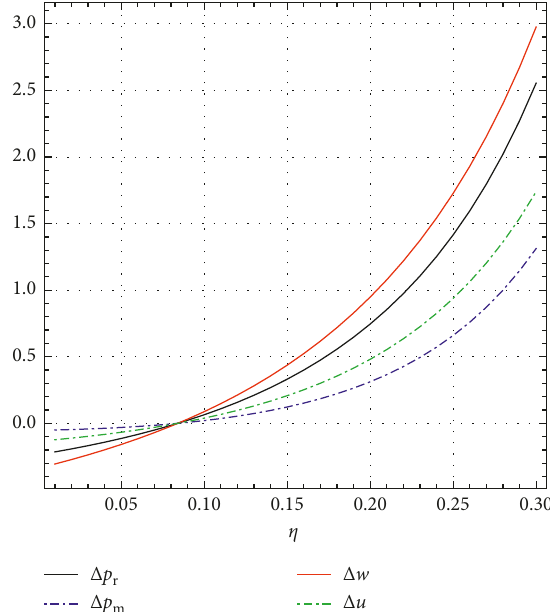
Figure 5: Comparison of steady-state decisions with k .